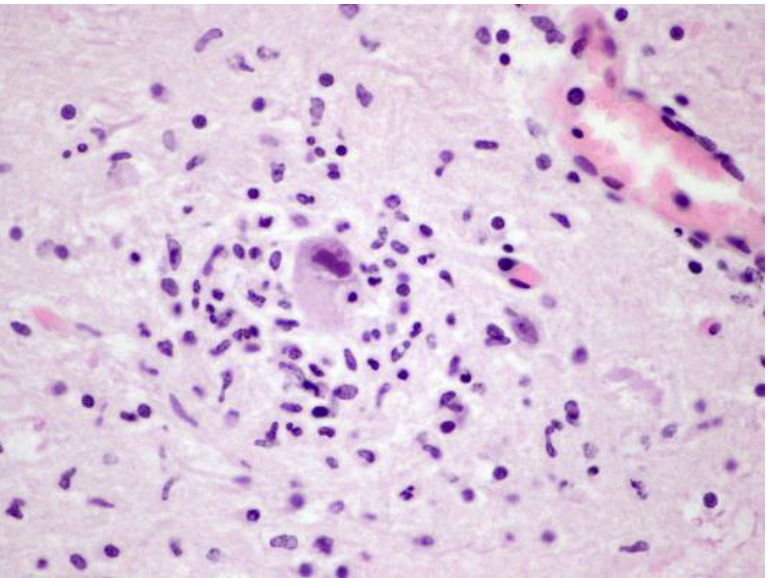
Figure 4 . Brain cerebral cortex sample of case 10, a juvenile female striped dolphin presenting 5/7 of the evaluated brain lesions. A neuronophagic nodule surrounding a neuron with a basophilic intranuclear inclusion body is present. Original magnification × 60; haematoxylin and eosin staining. Case 11, a calf female Atlantic spotted dolphin (nt sequence of 213 length) showed the highest nt similarity (92.56%) (100% QC) with a sequence detected in a pool of tissue samples from a common dolphin stranded on the coast of Portugal in 2011 (GenBank Acc.